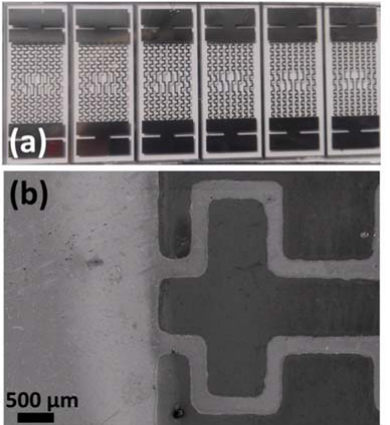
Figure 8. (a) Optical digital image of a real Figure 9. (a) Optical digital image of six real microheaters on glass substrate; and (b) SEM image of a microheater on glass width of about 100 μ m. substrate with the width of 200 μ m.